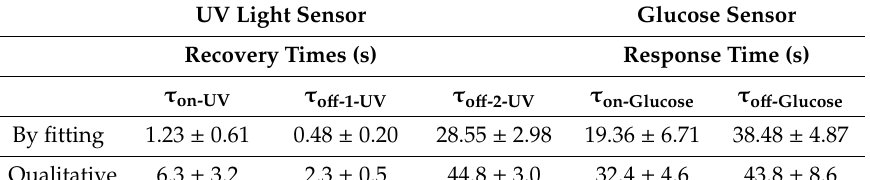
Table 1. Table with response time and recovery times value to UV and GLU sensor.